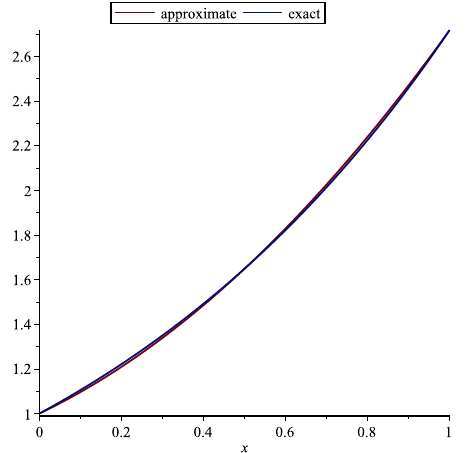
Figure 7. The approximate and exact solution of u 1, approx ( x ) for Example 7.